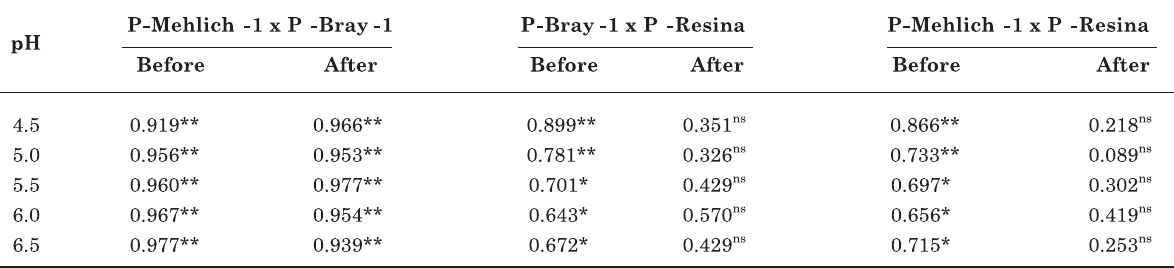
Table 11. Simple linear correlation coefficients between the contents of phosphorus extracted from soil through extractants Mehlich-1, Bray-1 and Resin, before and after the adjustment of different pH values to